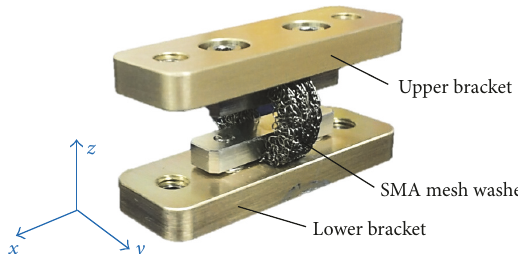
Figure 3: New application form of the ring-type SMA mesh washer